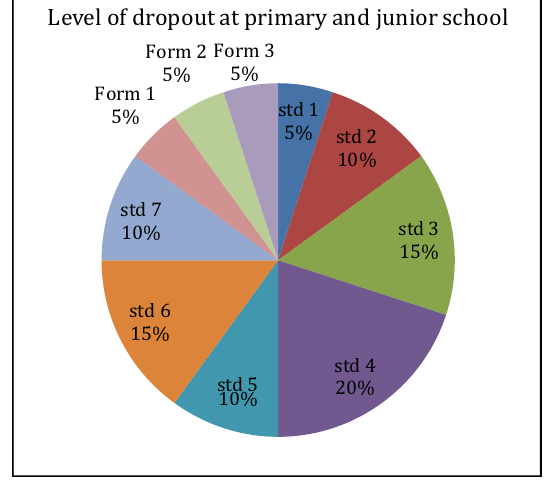
(Colour online) Level of